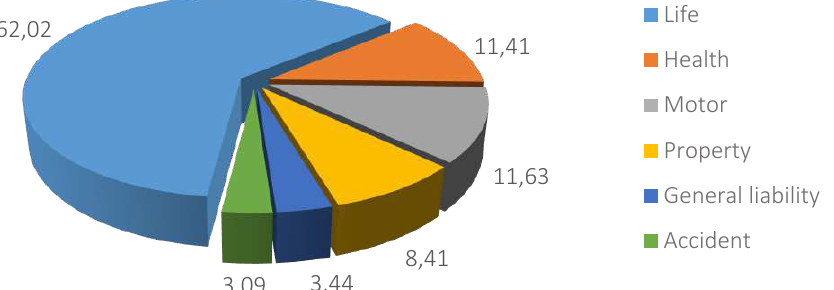
Figure 11. Structure of gross direct health premiums written on domestic market in Europe, %,